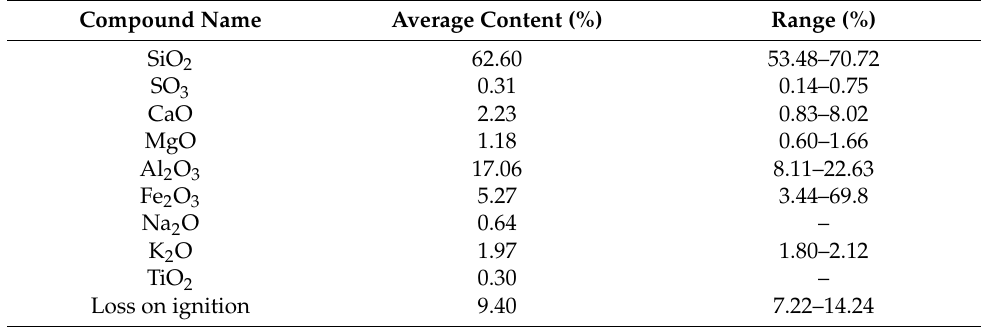
Table 2. Chemical analysis of Pliocene clays used in the production of tested ceramic building materials (clay masonry